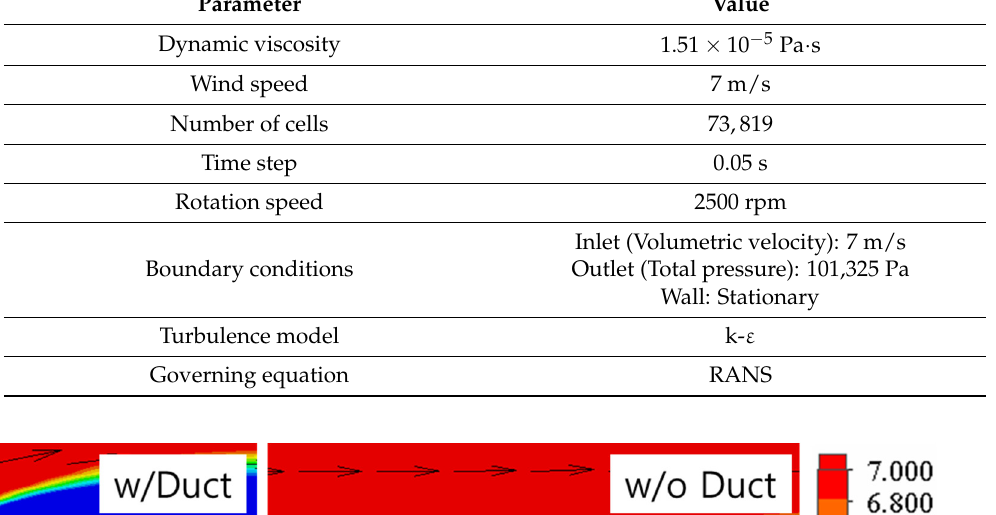
Table 2. Simulation parameters.